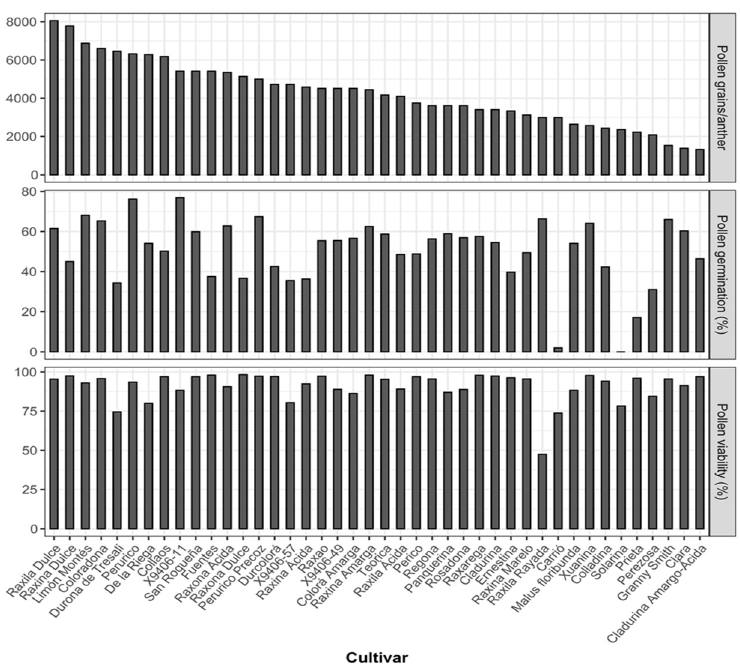
Figure 1. Means of pollen grains per anther, pollen germination (%) and pollen viability (%) of 41 apple cultivars in Villaviciosa (north-western Spain) across two successive years (i.e., 2018–2019 or 2019–2020).